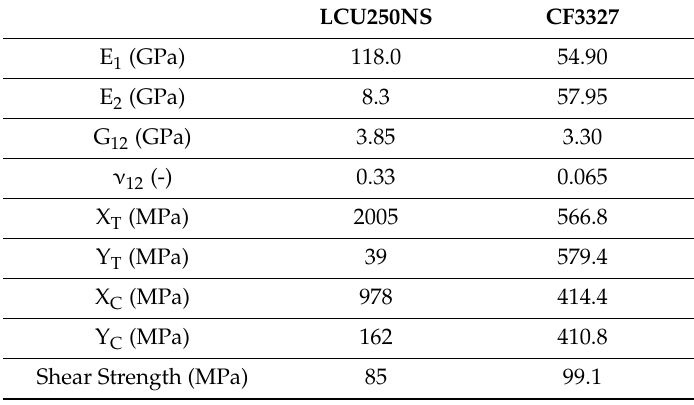
Table 3. Properties of the carbon composite materials.